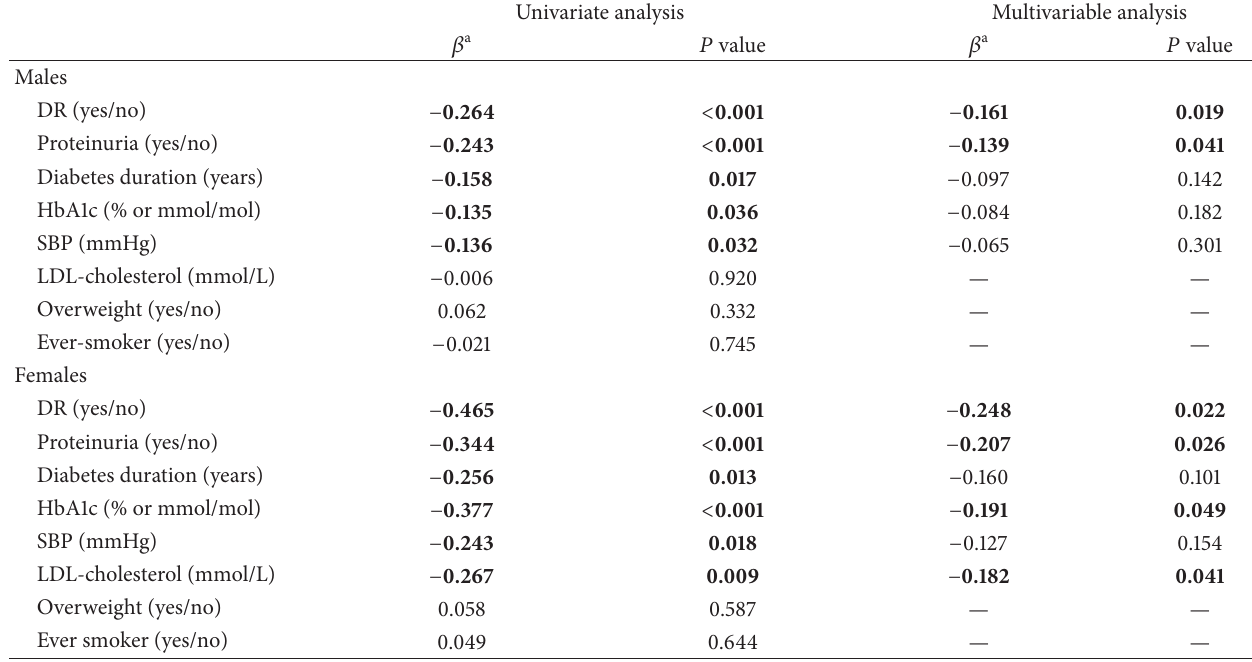
Table 2: The relationships between baseline variables and the annual eGFR change in males and females. Univariate analysis Multivariable analysis